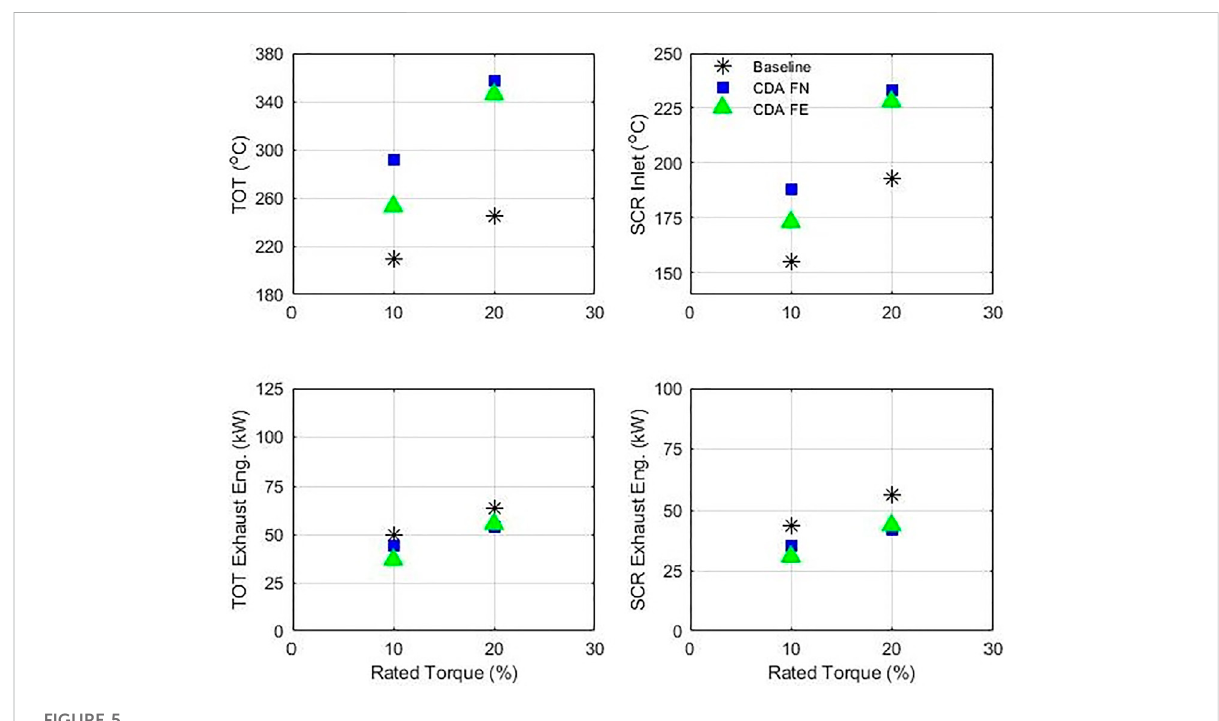
FIGURE 5 1000 rpm steady state exhaust